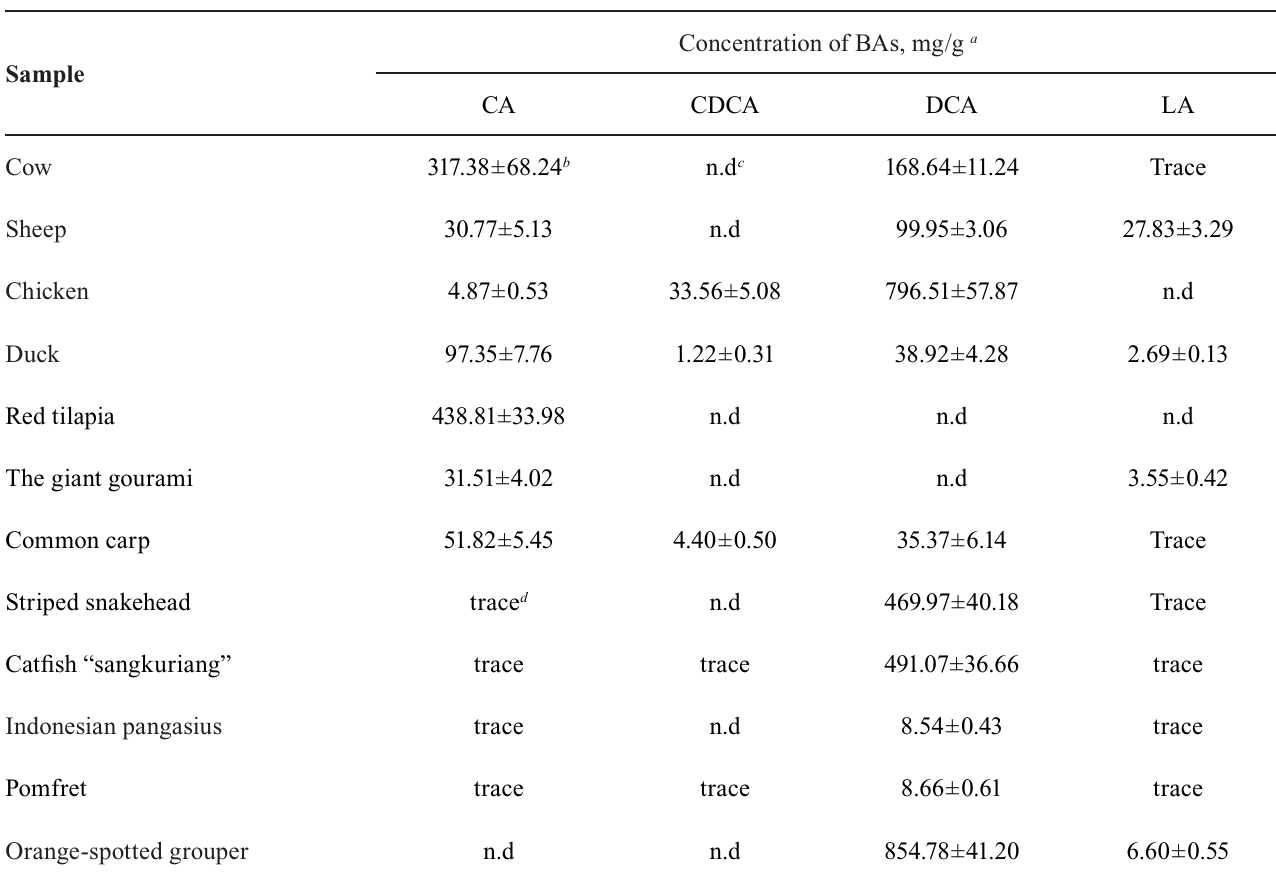
TABLE III - Biliary BA composition of the selected animals